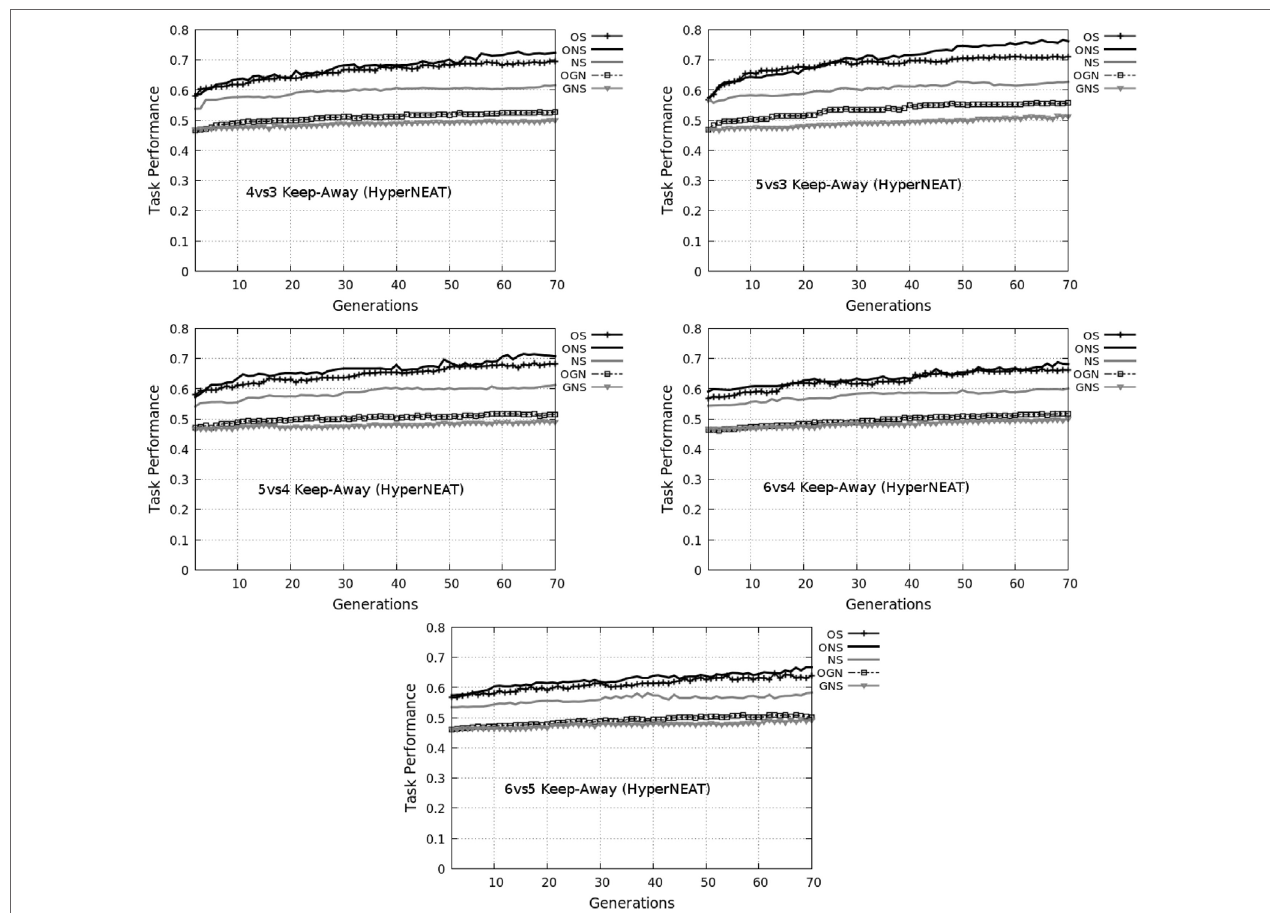
FigUre 5 | Average maximum task performance progression (given policy transfer), over 20 runs in each task, for each HyperNEAT. OS, objective-based search ; NS, novelty search ; ONS, objective-novelty search ; GNS, genotypic novelty search ; OGN, objective-genotypic novelty search . Note: ONS variant consistently evolves behaviors with the highest maximum task performance (observable at each final generation), and progression is over 70 generations for consistency with non-policy transfer